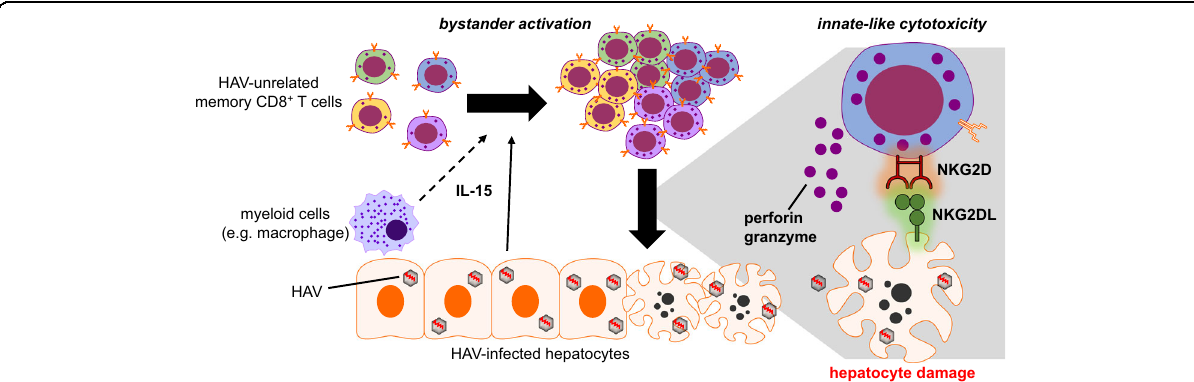
Fig. 2 Pathological role of bystander-activated CD8 + T cells in acute hepatitis A virus (HAV) infection. During acute hepatitis A, memory CD8 + T cells speci fi c for HAV-unrelated viruses undergo IL-15-dependent bystander activation. IL-15 is produced by hepatocytes and possibly myeloid cells in the infected liver. These activated, HAV-unrelated CD8 + T cells exhibit “ innate-like cytotoxicity ” to hepatocytes, which is triggered by the ligation of natural killer cell-activating receptors (e.g., NKG2D) with their